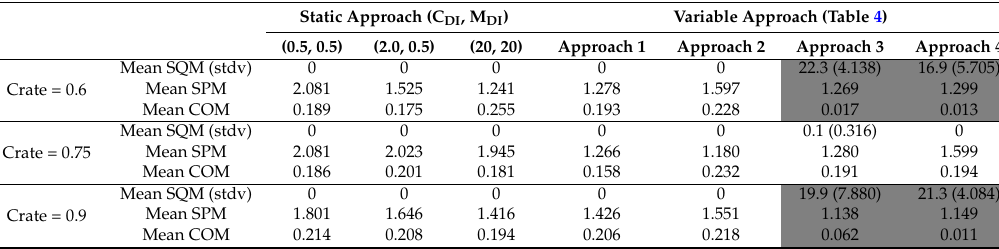
Table 7. Performance metrics of all 21 static and variable cases. The total number of global Pareto solutions is 805.